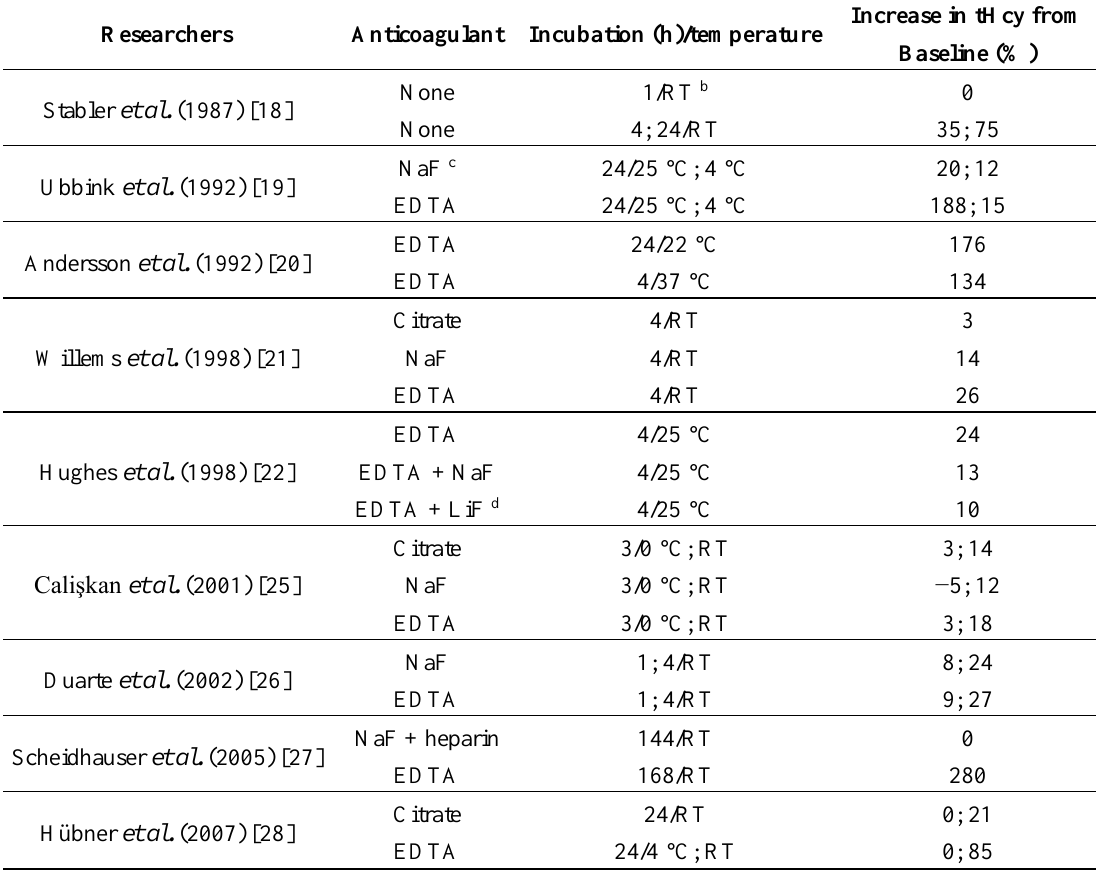
Table 1. Change in plasma total homocysteine (Hcy) concentrations by anticoagulant, temperature and time elapsed before sample processing a .